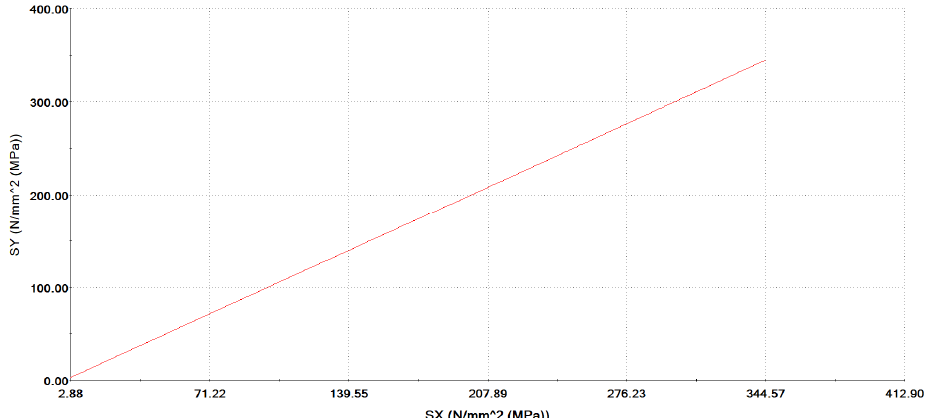
of the cruciform specimen during the time in the simulation.